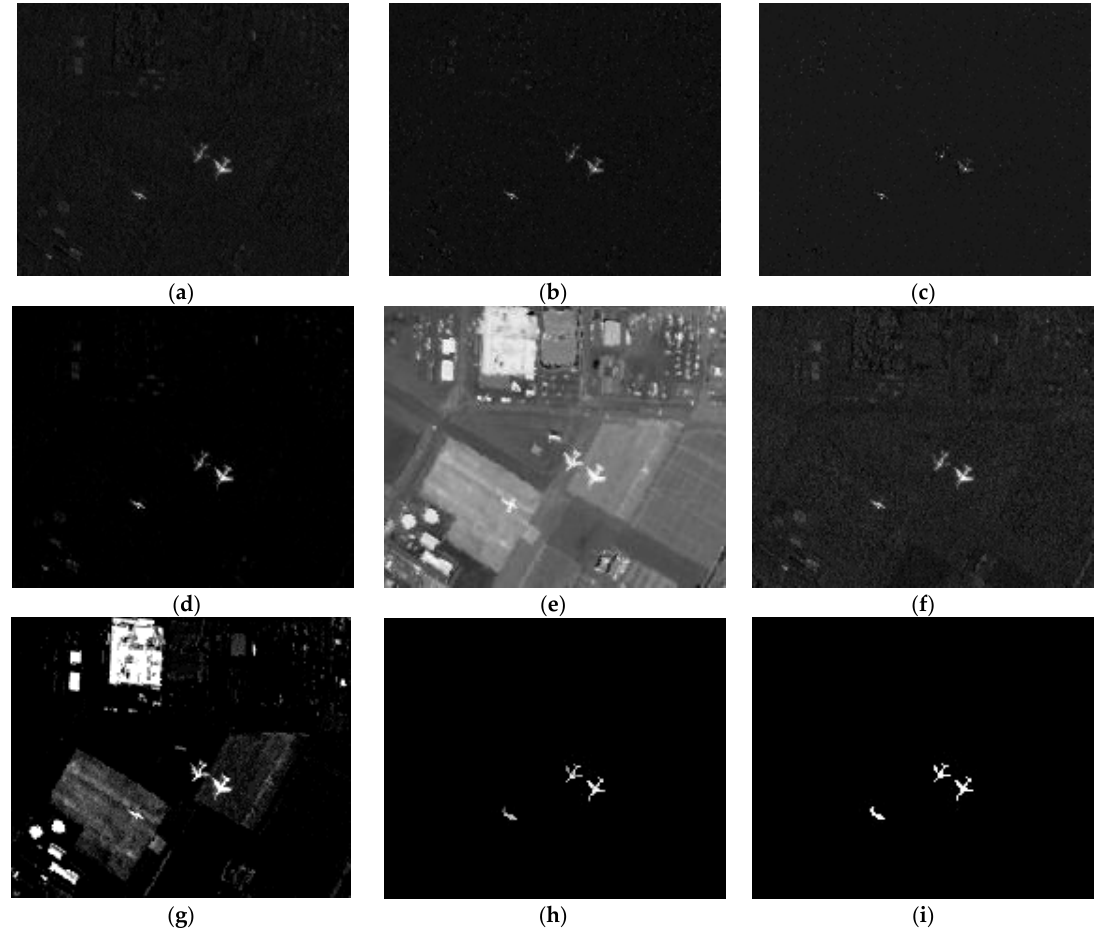
Figure 9. Detection results of the AVIRIS data: ( a – c ) results of the hCEM algorithm for the first to third layers; ( d ) results of CEM algorithm; ( e ) results of SAM algorithm; ( f ) results of CE algorithm; ( g ) results of MPCEM algorithm; ( h ) results of SWCEM algorithm; and ( i ) reference data.